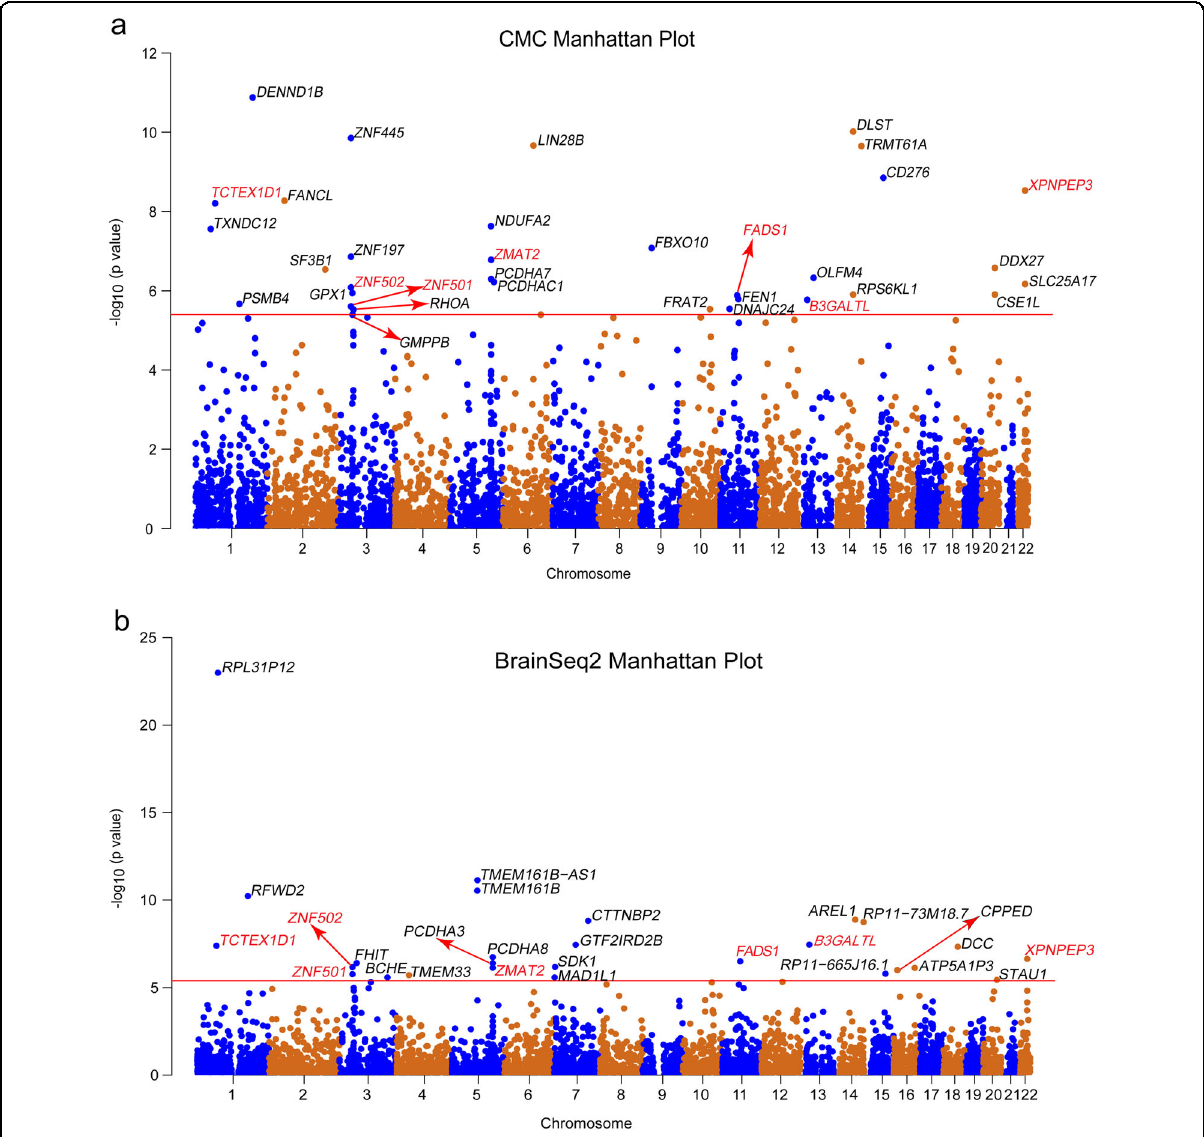
Fig. 1 Manhattan plot of the TWAS results for depression (246,363 cases and 561,190 controls). a Manhattan plot of TWAS results in CMC dataset (a total of 33 signi fi cant genes detected). b Manhattan plot of TWAS results in BrainSeq2 dataset (a total of 27 signi fi cant genes detected). Each point represents a gene, with physical genomic position (chromosome, basepair) plotted on the x -axis and association P- value (the − log 10 (FUSION P -value)) between gene expression in the DLPFC and depression plotted on the y -axis. Bonferroni-corrected signi fi cant genes are labeled and the signi fi cance threshold of P = 7.91 × 10 − 6 was used. Seven genes reached transcriptome-wide signi fi cance in both two expression panels (including B3GALTL , FADS1 , TCTEX1D1 , XPNPEP3 , ZMAT2 , ZNF501 and ZNF502 ) and are highlighted in red